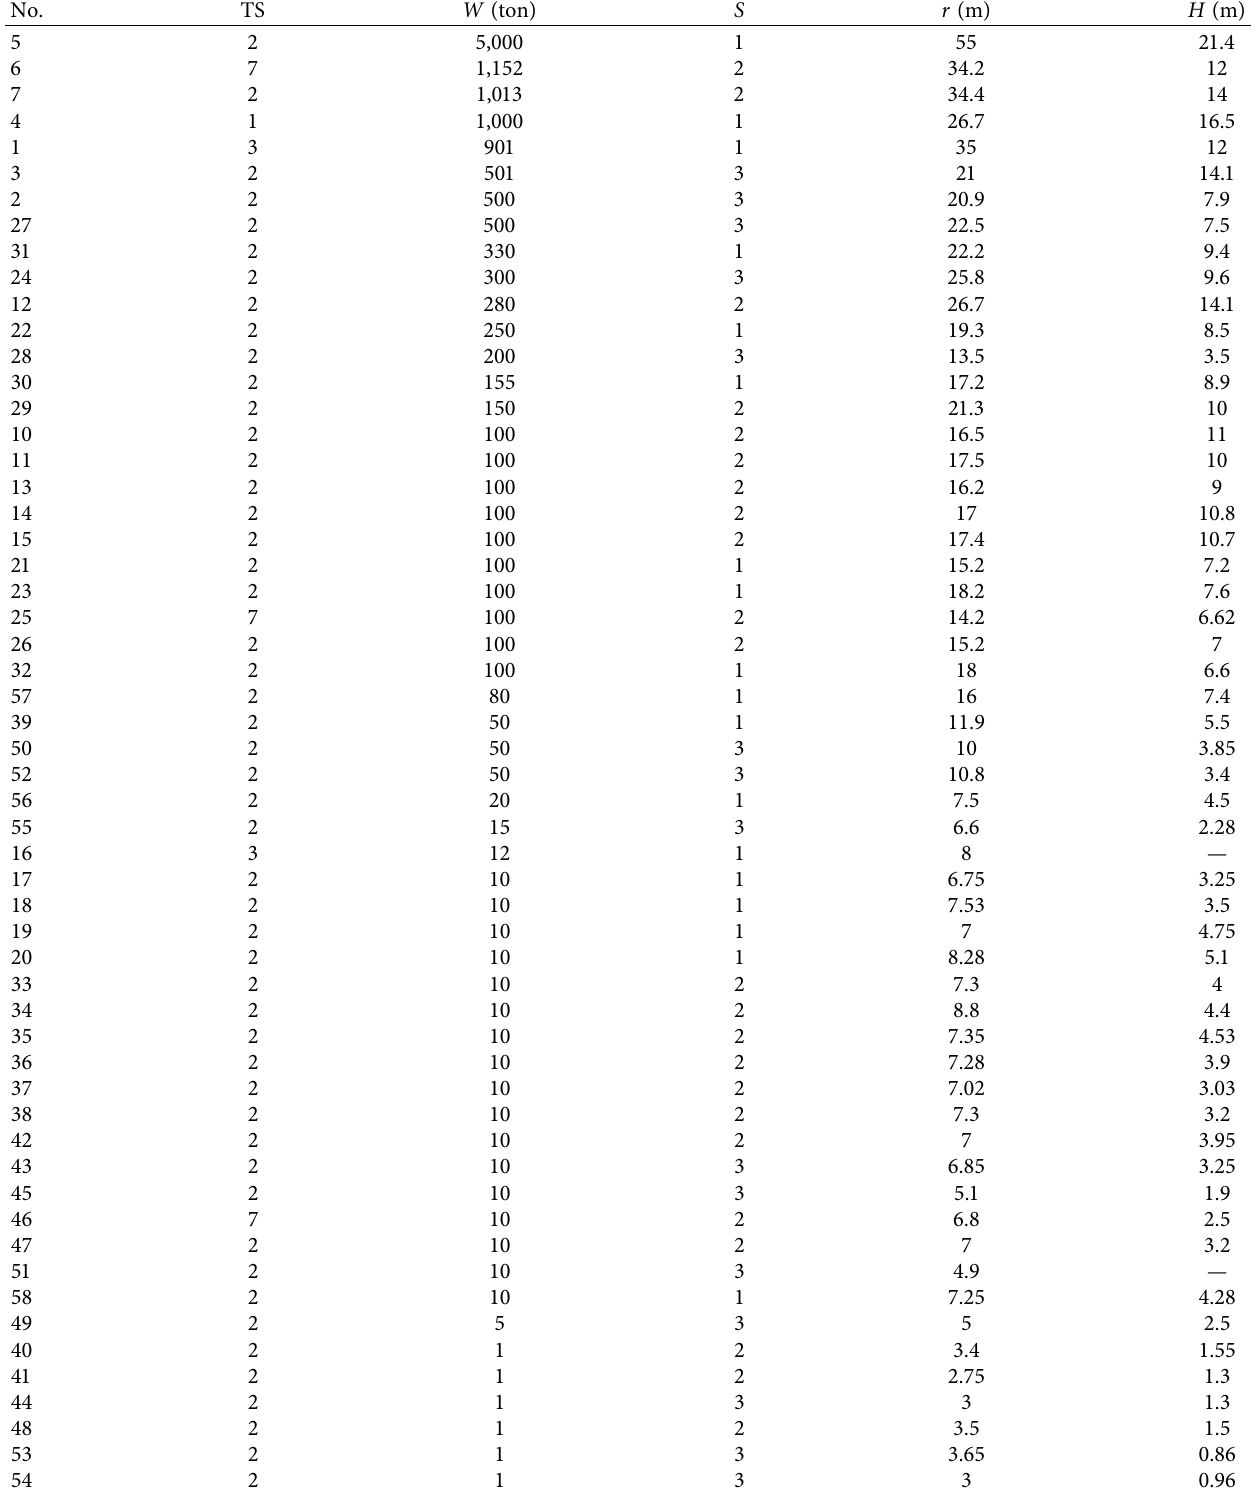
Table 13: Previous test data of large-scale surface explosion craters